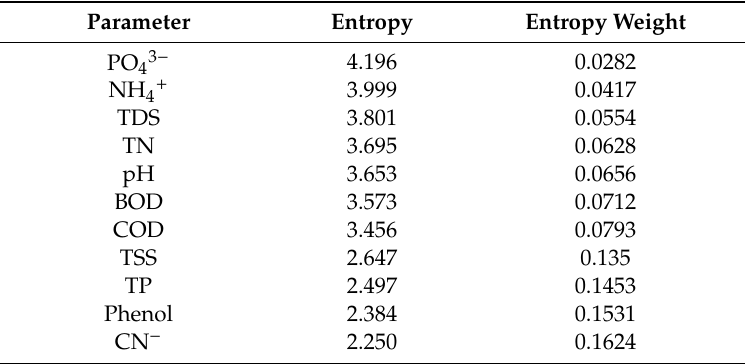
Table 2. Entropy and entropy weights of wastewater